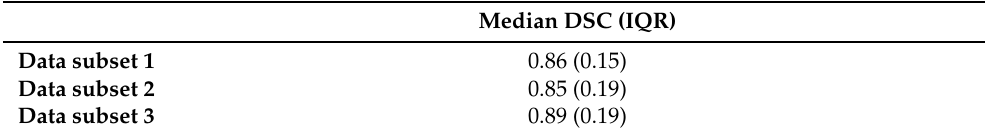
Table 3. Median DSC of the final segmentation method on three different randomly selected subsets.